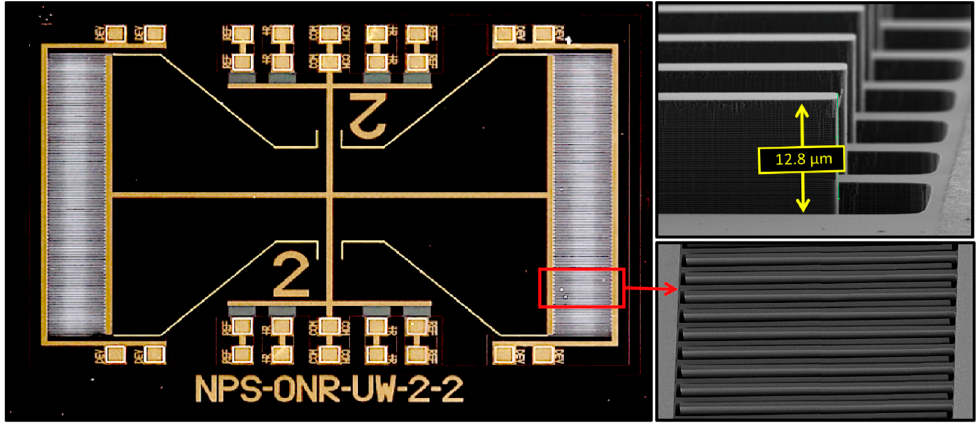
Figure 10. Photograph of the fabricated two-wing sensor (left side) with expanded view (SEM micrograph) of the comb finger capacitors used for electronic readout of the signal. Note that the fingers from the sensor overlap with the fingers from the substrate due to the reduced size of the wing.